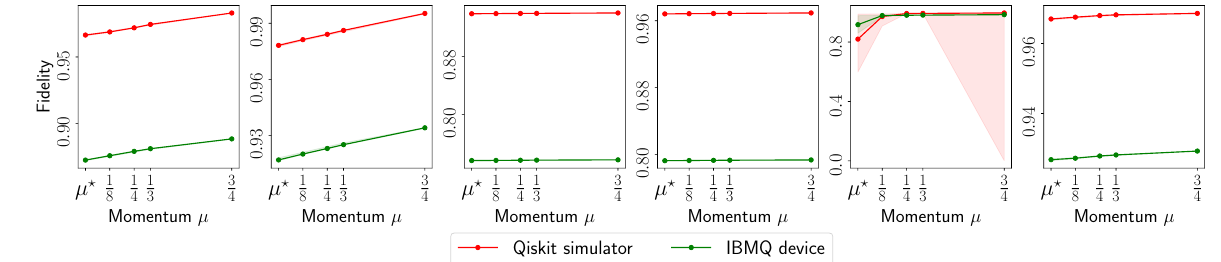
( 6 ) with ρ to ρ (cid:63) . From left to right : (i) GHZ − ( 8 ) with 2048 shots; (iv) GHZ ( 8 ) with 4096 shots; − − (cid:98)